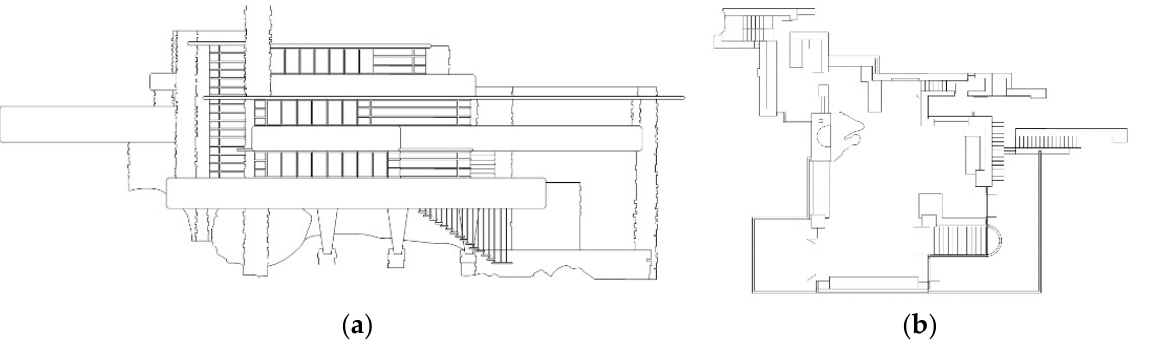
Figure 3. Fallingwater (1937). ( a ) Elevation and ( b ) plan.